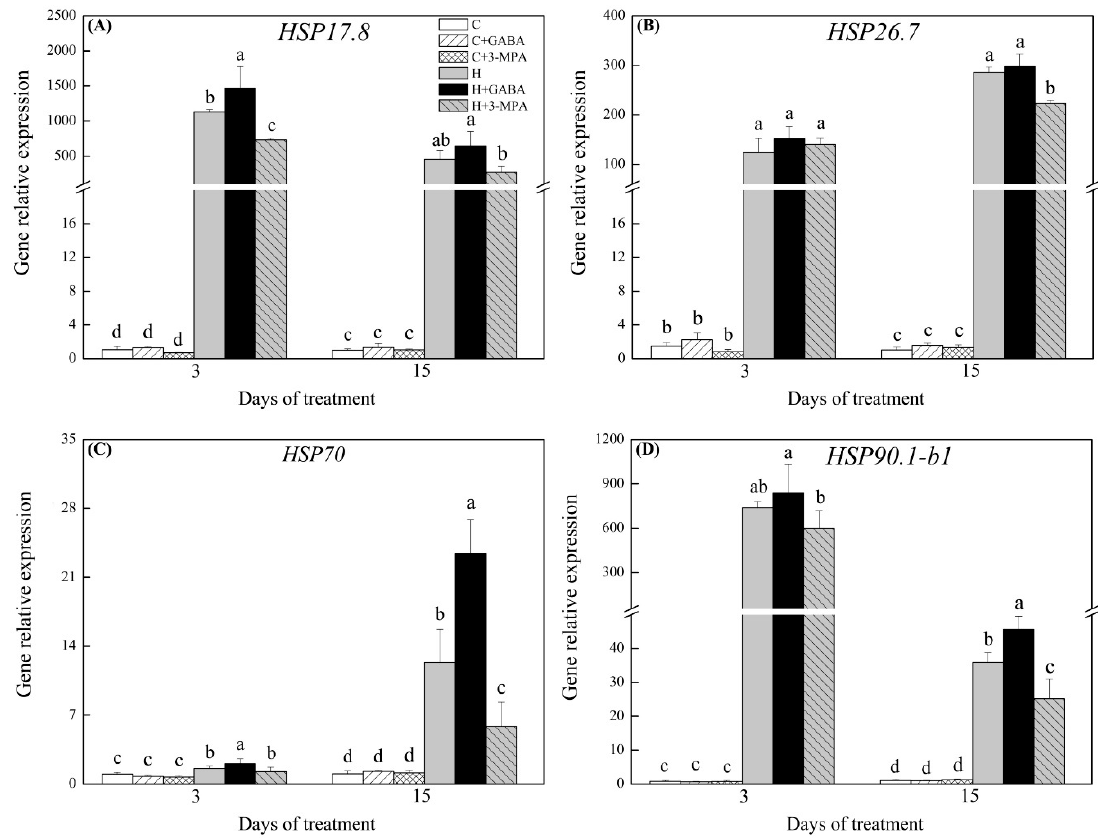
Figure 7. E ff ects of γ -aminobutyric acid (GABA) and 3-mercaptopropionic acid (3-MPA) on ( A ) HSP17.8 ( B ) HSP26.7 , ( C ) HSP70 , and ( D ) HSP90.1-b1 relative expression in leaves of creeping bentgrass at 3 and 15 d of 23 / 18 (normal condition) or 38 / 33 ◦ C (heat stress). Vertical bars above columns indicate ± standard error (SE) of means ( n = 4) and di ff erent letters above columns indicate significant di ff erences ( p ≤ 0.05). C: control; C + GABA: control + GABA; C + 3-MPA: control + 3-MPA; H: heat; H + GABA: heat + GABA; H + 3-MPA: heat +